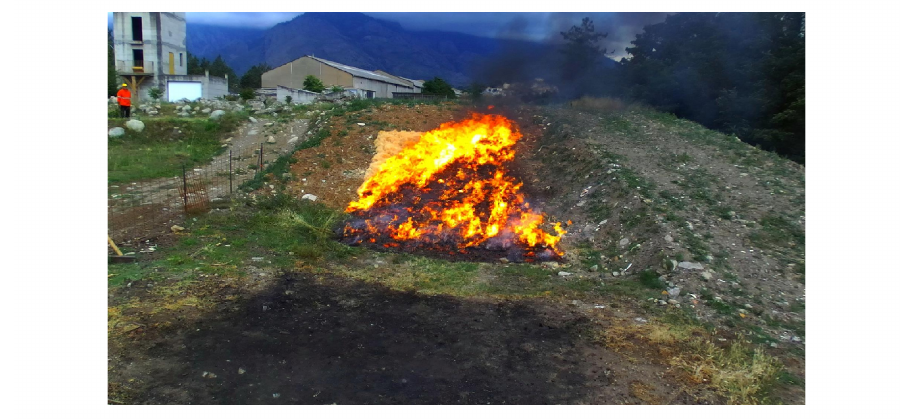
Figure 28. Image of the fire after a few minutes of propagation.